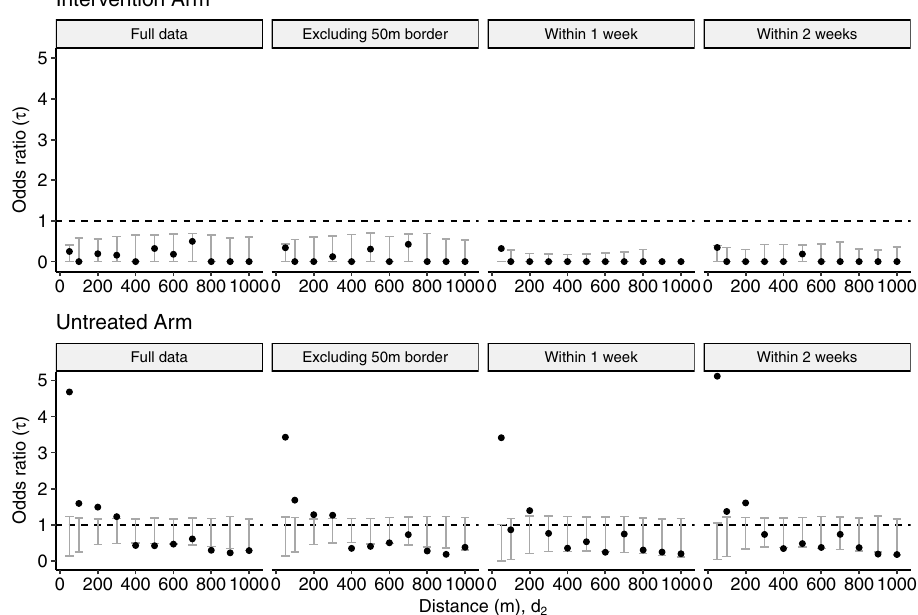
Figure 6. Sensitivity analyses and comparison with the primary analysis. Modified geometric mean odds ratio, τ , comparing the odds of a homotypic dengue case pair within the distance interval ( d 1 , d 2 ) versus the odds of a homotypic dengue case pair at any distance across the entire study area for (1) the full dataset, (2) the dataset excluding those within 50 m of a cluster border, (3) participant pairs with illness onset occurring within 1 week of each other, and (4) participant pairs with illness onset occurring within 2 weeks of each other. The error bars denote the 95% CI on the null distribution generated by 1000 permutations of the